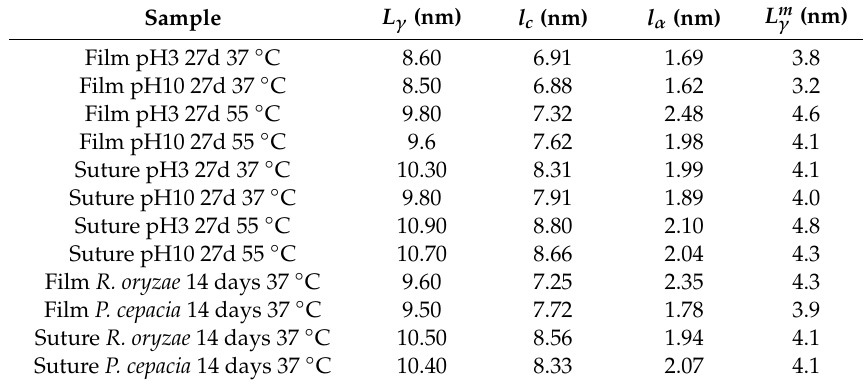
Table 3. Morphological parameters of films and sutures exposed to degradation at the indicated media.